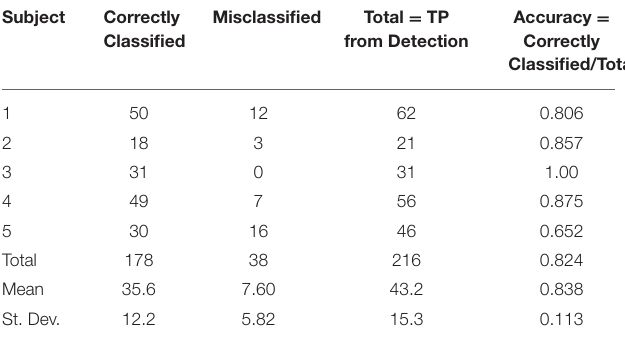
TABLE 2 | Three-plate experiment bite classification